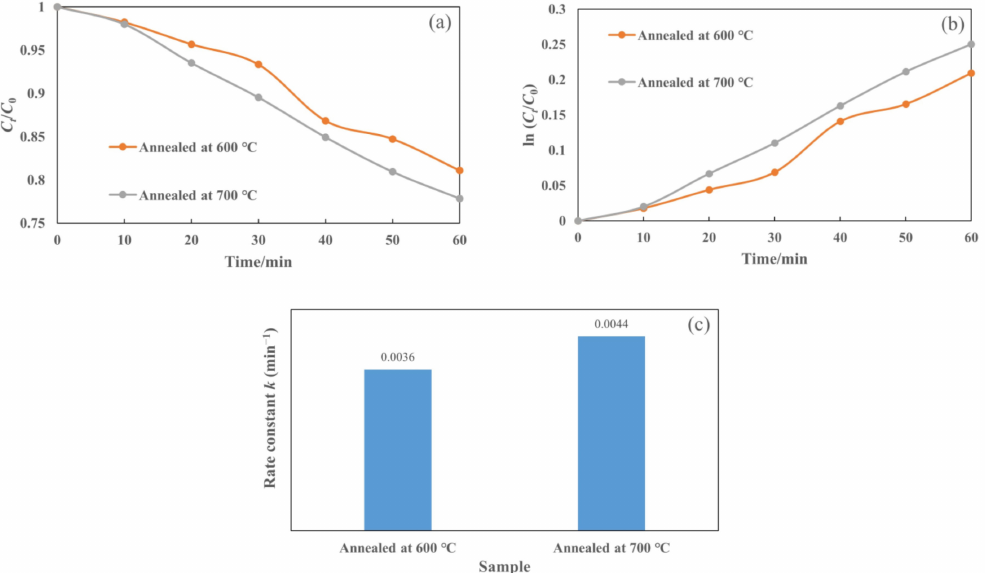
Figure 10. Photocatalytic degradation of rhodamine 6G by T-C-A films annealed at different tempera- tures: ( a ) degradation with respect to time, ( b ) ln ( C t / C 0 ) versus to time plot, and ( c ) corresponding rate constants of degradation for